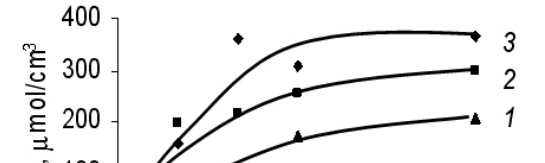
Figure 4. Changes of tellurium (a) and sulfur (b) concentrations in PA film, chalcogenized in 0.05 mol dm -3 K Temperatures of chalcogenization solution, o C: 1 – 1, 2 – 10, 3 – 20